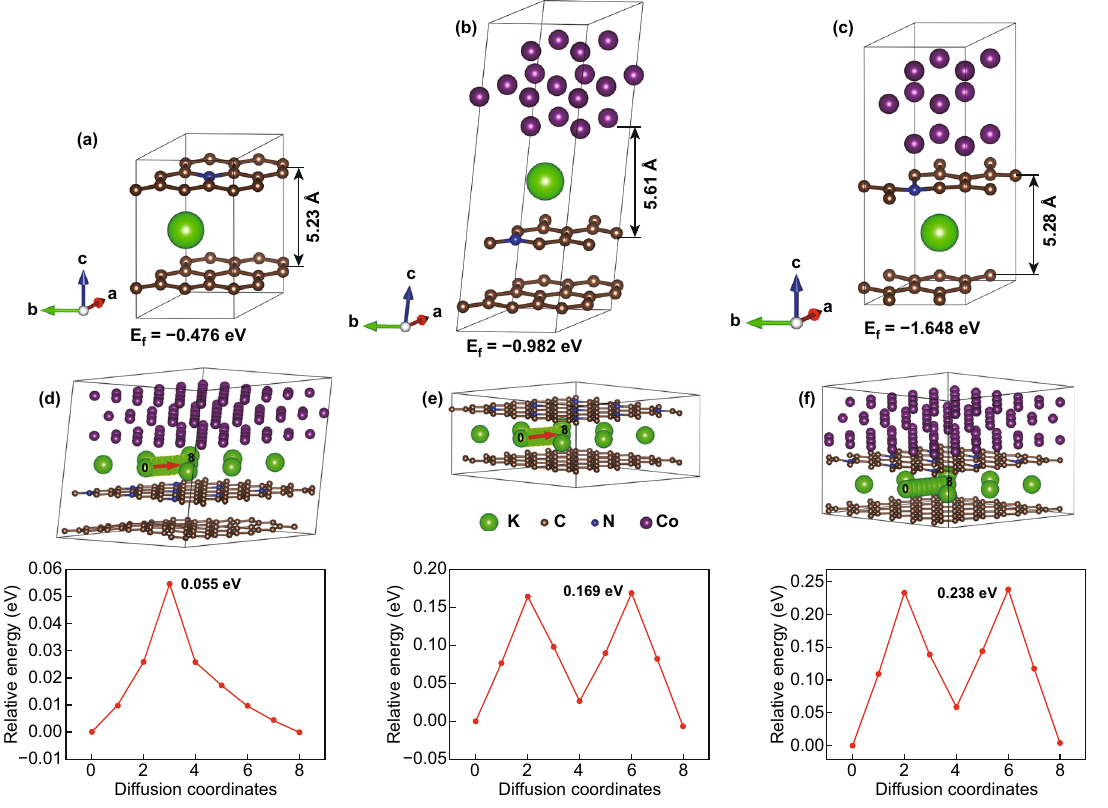
Fig. 4 Adsorption energy of K + ion a at the carbon layer of NC, b at the interface of cobalt nanoparticles and NC, and c at the carbon layer of Co-NC; corresponding barrier energy for K + ions diffusing d at the interface of cobalt nanoparticles and NC, e between the carbon layers of NC, and f between the carbon layers of